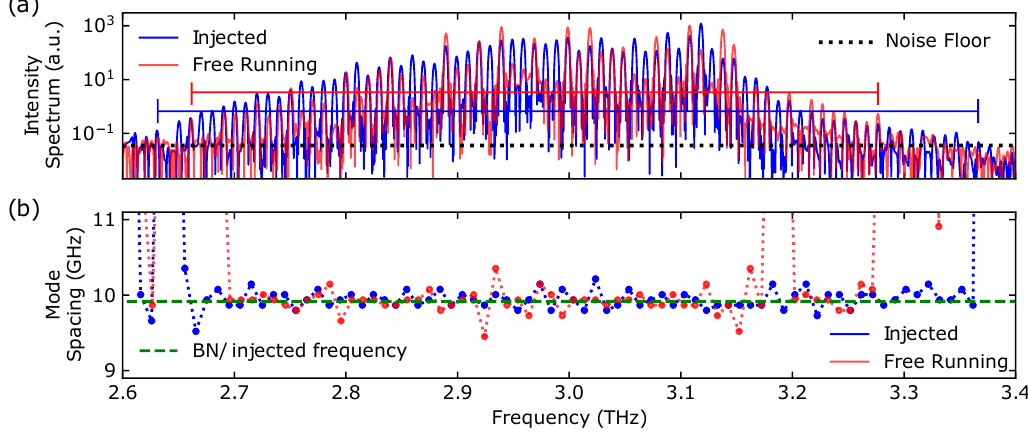
Figure 5. ( a ) Free running (single beatnote regime, 714 mA) and corresponding strong injected spectra at 80 K. Significant change in the modes as well as generation of additional modes due to injection which leads to a spectral bandwidth from 600 GHz to 700 GHz. ( b ) Mode spacing extracted from ( a ) showing a quantitative agreement of the equally spaced